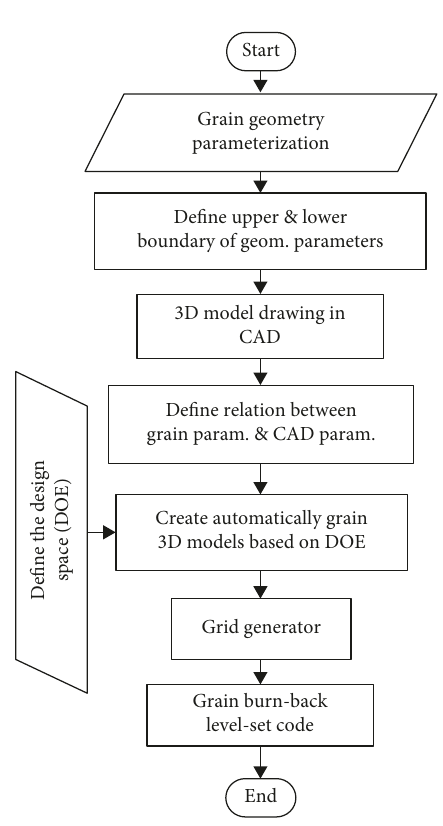
Figure 3: Initial grain model preparation fl